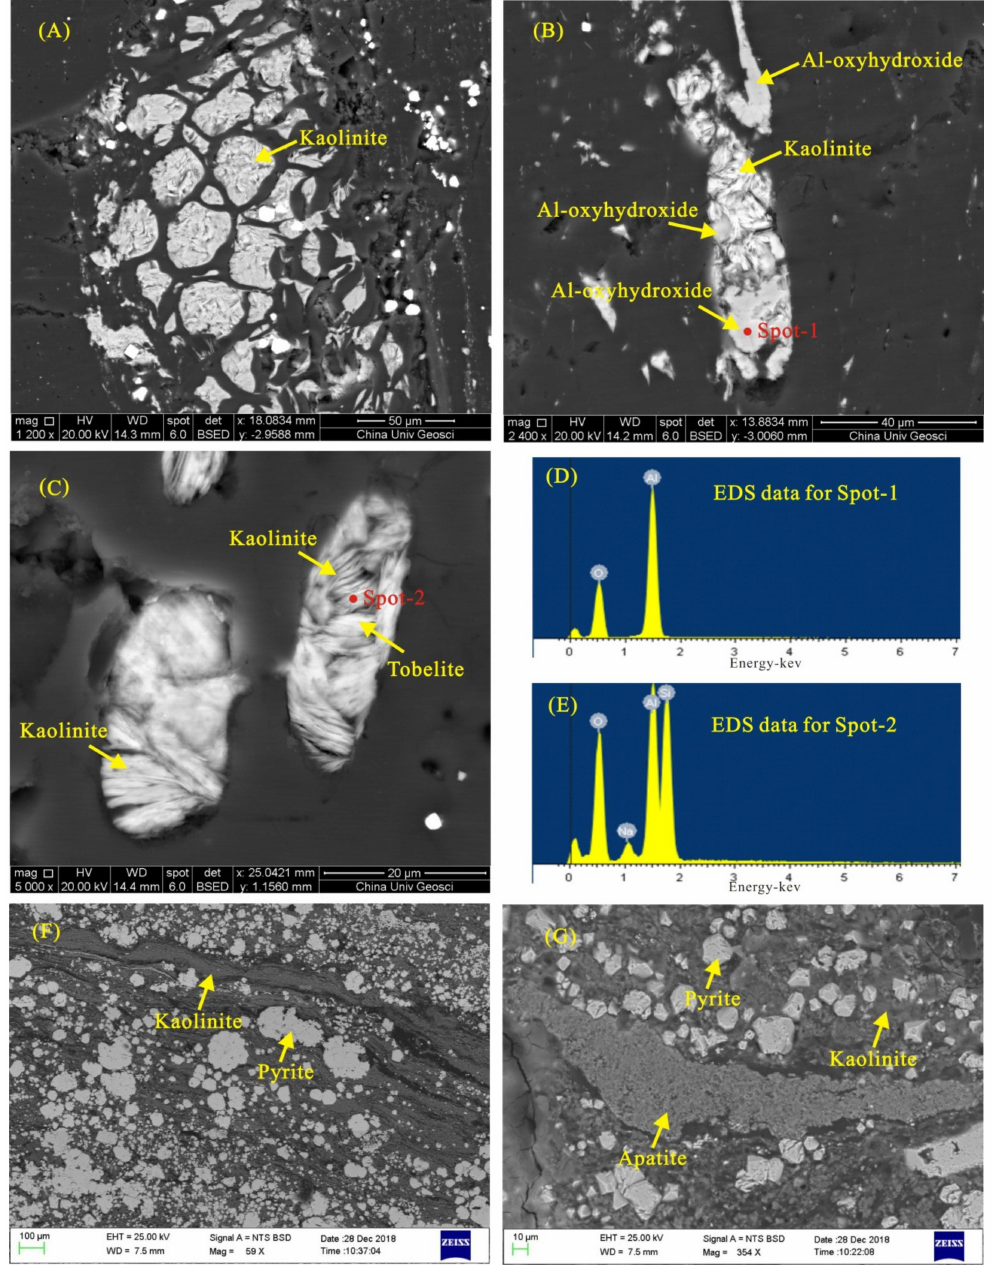
Figure 7. SEM back-scattered electron images of minerals in coal (sample CLB4-12) and floor (sample CLB4-F1) samples and energy-dispersive X-ray spectrometer (EDS) analysis of selected minerals. ( A ): cell-filling kaolinite; ( B ): kaolinite, along with Al-oxyhydroxide minerals, occurring as pore space infillings; ( C ): intergrowth of kaolinite and tobelite; ( D ): EDS spectra of Al-oxyhydroxide minerals; ( E ): EDS spectra of kaolinite containing traces of Na; ( F ): massive pyrite and kaolinite matrix; ( G ): massive pyrite, kaolinite matrix, and lath-like